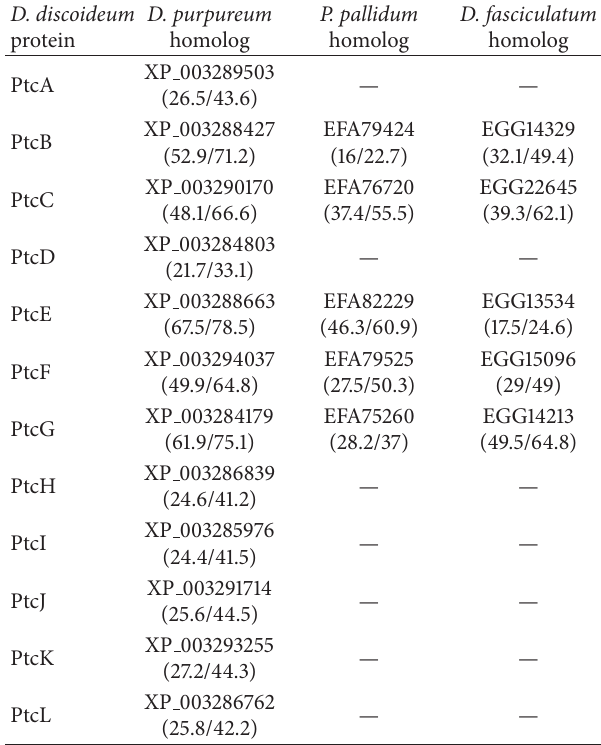
Table 2: Putative homologs of D. discoideum PPR proteins in other cellular slime moulds. The presence of a homolog is noted by the NCBI protein accession number while the absence of a clear homolog is denoted by “—”. Also, indicated in the parentheses are the levels of amino acid identity/similarity (%), respectively, for each protein compared to the D. discoideum homolog as determined by end to end pairwise alignments.